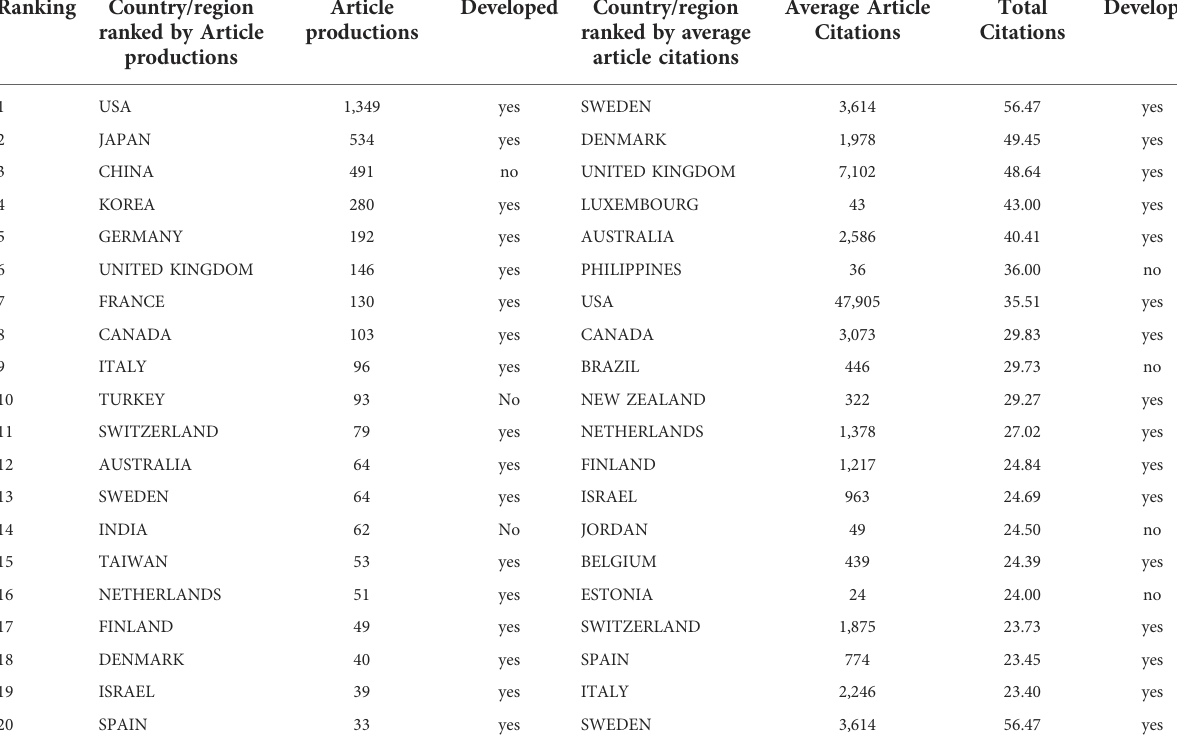
TABLE 3 Top-20 productive and in fl uential countries/regions in the fi eld of lumbar spondylolisthesis.